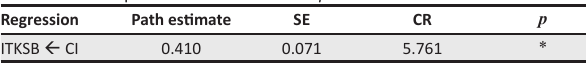
TABLE 5: Model parameter estimates and p -value.